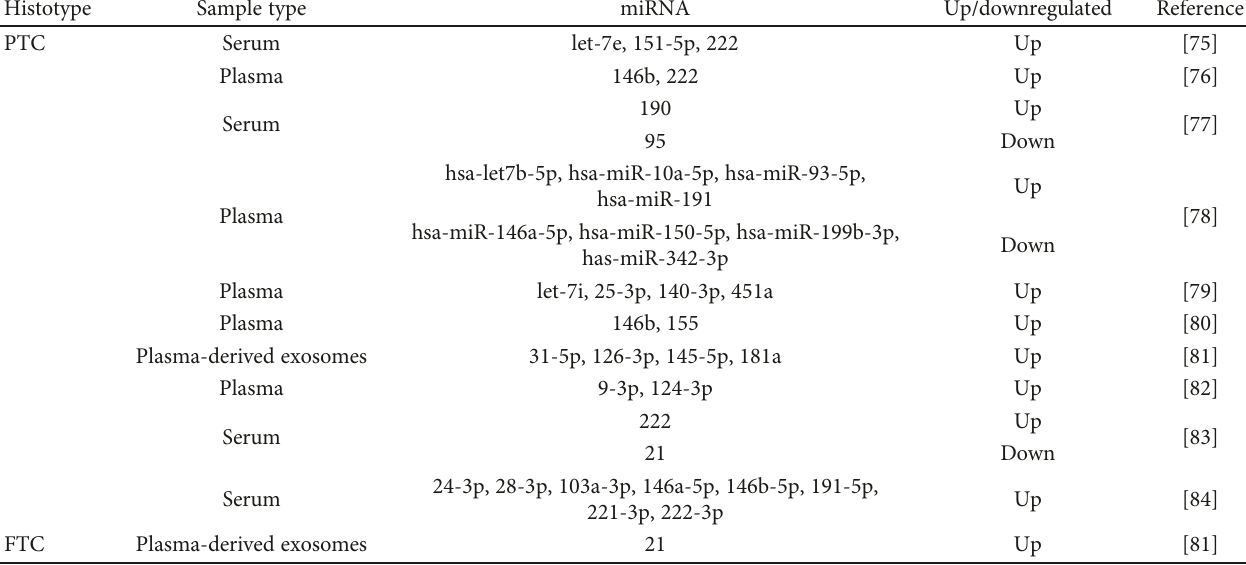
Table 3: Circulating miRNAs as diagnostic biomarkers in thyroid